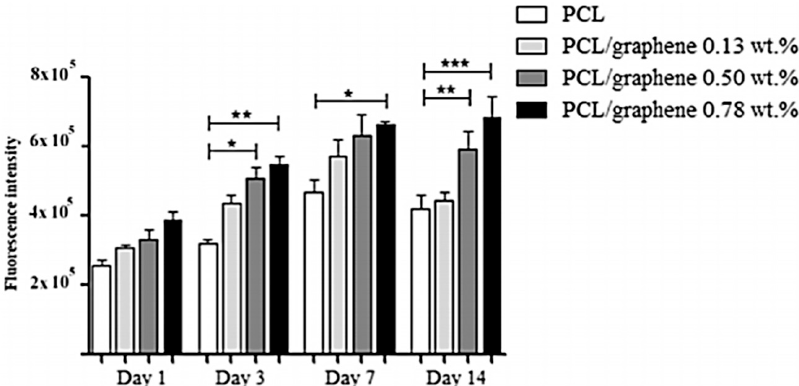
Figure 5. MC3T3 osteoblasts viability and proliferation measured by fluorescence intensity for G-containing PCL scaffolds. The higher the G content, the higher the cell proliferation rate. ( * ) Statistical analysis difference p < 0.05; ( ** ) p < 0.01; ( *** ) p < 0.001 (reprinted from [93], with permission from Elsevier).